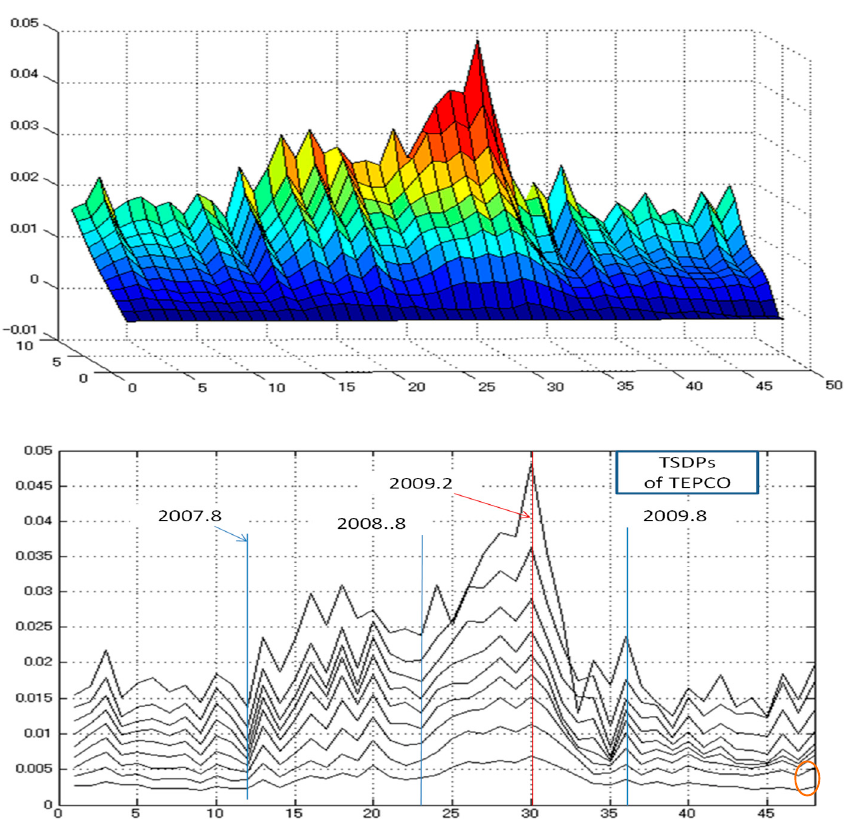
Figure 13. Time series movements of TEPCO’s TSDPs from September 2006 through August 2010. The 30th month corresponds to February 2009. The upper graph describes 3D movements of the TSDPs, while the lower one represents the time series variations of DPs { ( ): 1,2, ,48} s = 2, …, 10.